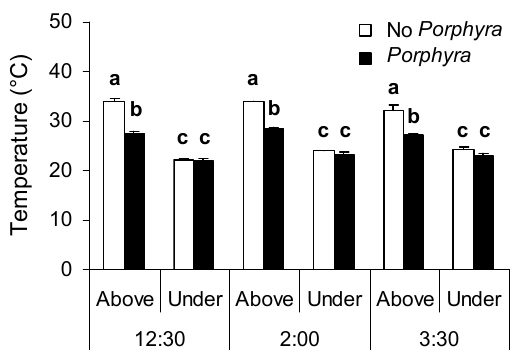
exposure period (Low tide at 1:59 PM). Different letters above bars indicate significant differences within each measurement time. Above Under Above Under Above Under